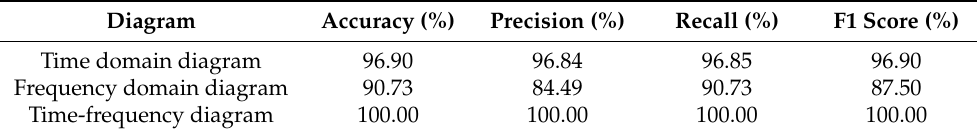
Table 5. Results of different